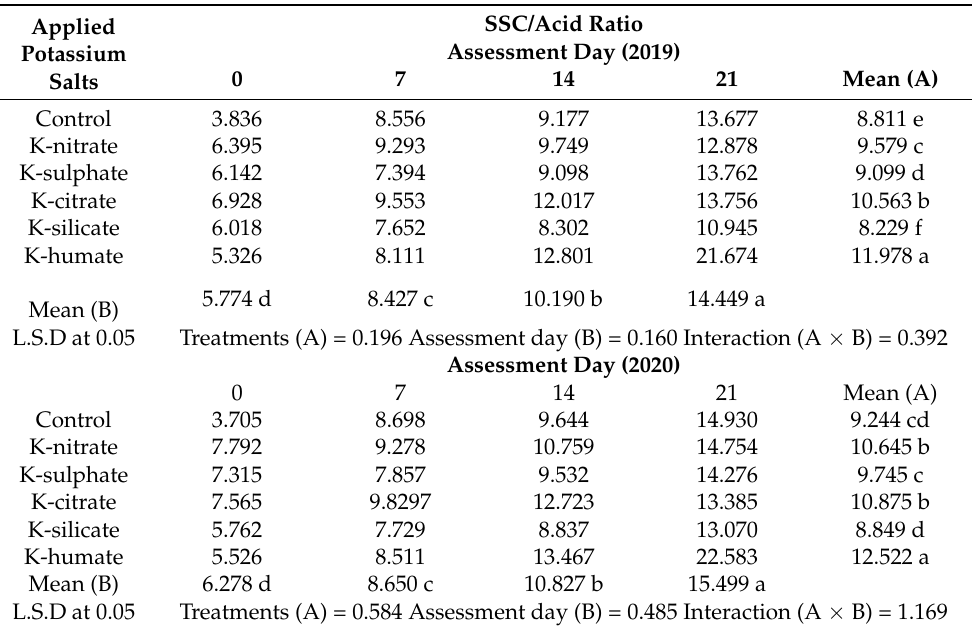
Table 8. Effect of diverse potassium forms as foliar application on SSC/Acid ratio of apricot fruits